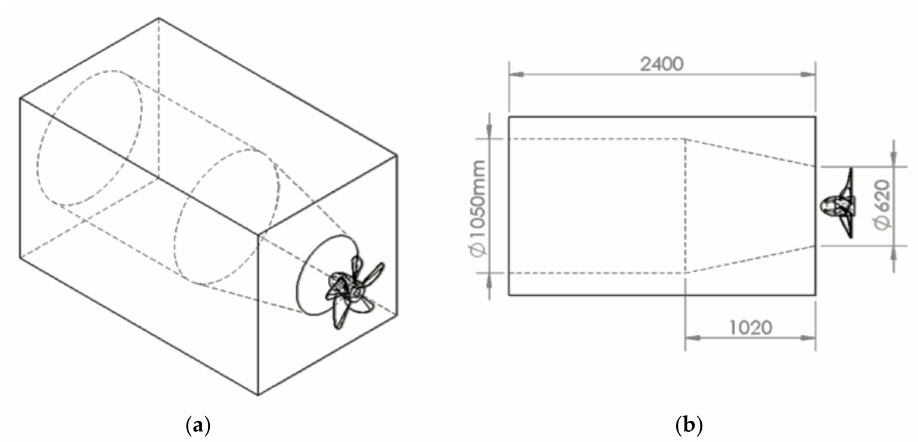
Figure 4. ( a ) The full-scale duct design considered for the current study was based on the lesson learned from the early testing. The turbine was added to the duct outlet. ( b ) The same design shown from the side, with dimensions shown in